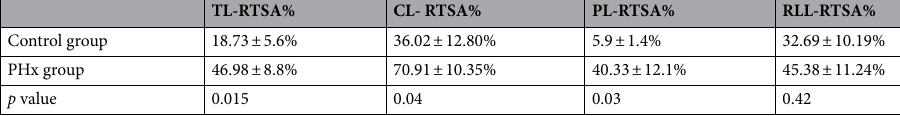
Table 2. Relative tumour surface area occupied by CRCLM in total liver mass (TL-RTSA%), caudate lobe (CL-RTSA%), paramedian lobe (PL-RTSA%) and right lateral lobe